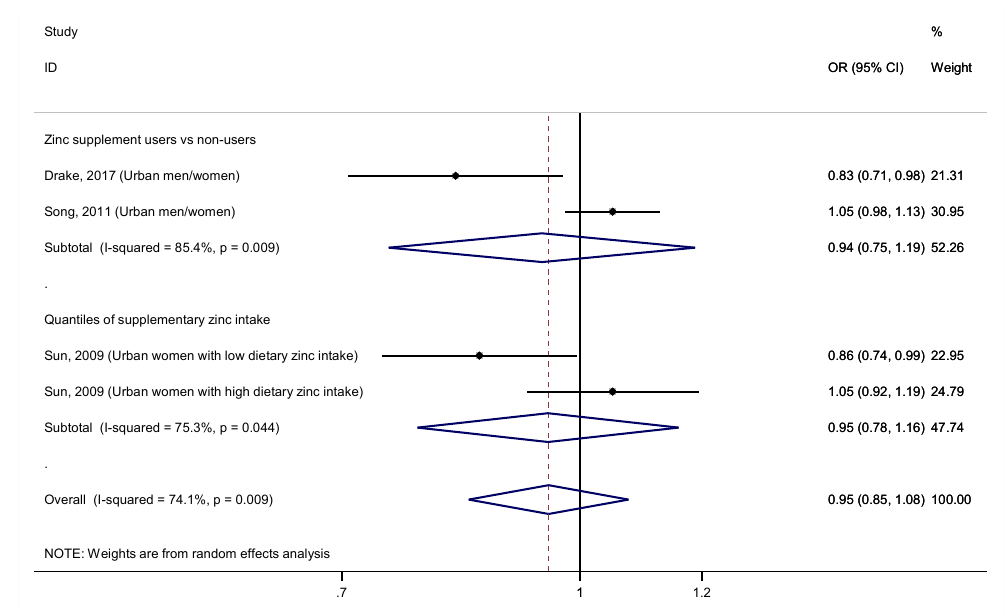
Figure 7. Forest plot of the pooled effect size of the highest versus lowest supplementary zinc intake for T2DM according to the analysis (zinc supplement users/non-users versus quantiles of supplementary zinc intake). Squares represent ORs for each study, and the size of the square is the study-specific statistical weight. Horizontal lines indicate the 95% CI of each study. Diamond represents the combined OR estimate with corresponding 95% CI.